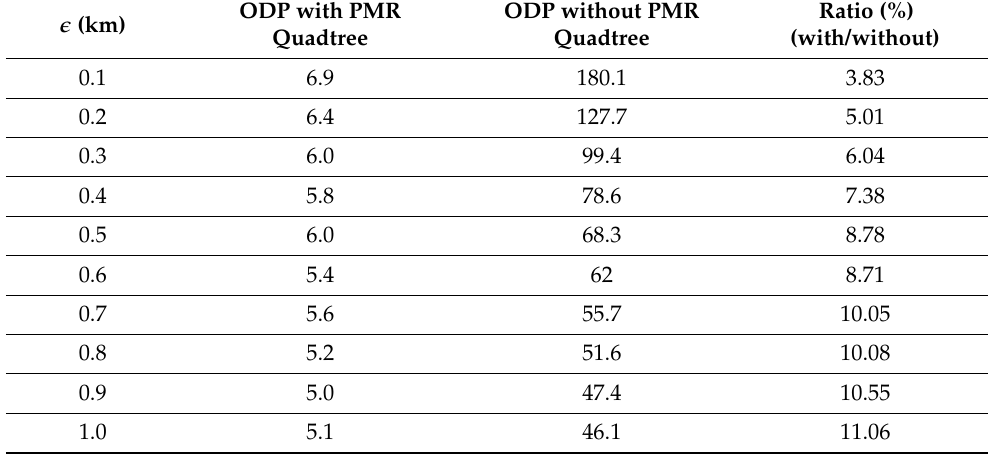
Table 6. Comparison of the computational efficiencies of the ODP algorithms with and without the PMR quadtree (Trajectory